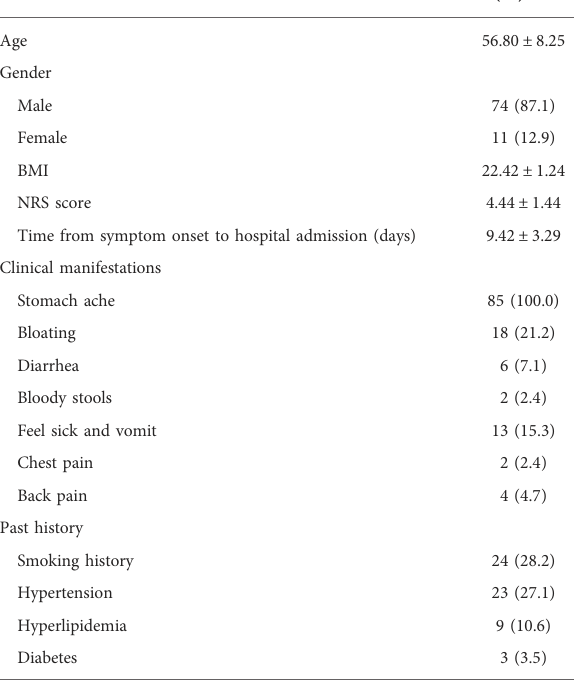
TABLE 1 General information of patients.